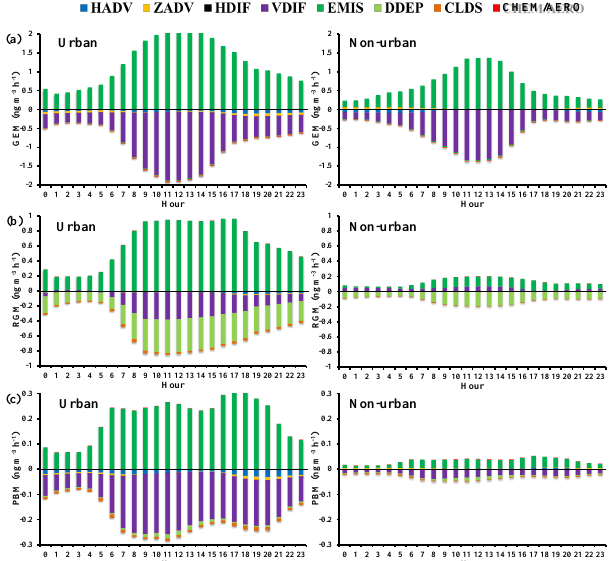
Figure 6. Diurnal variations of processes of (a) GEM, (b) GOM and (c) PBM in urban and non-urban